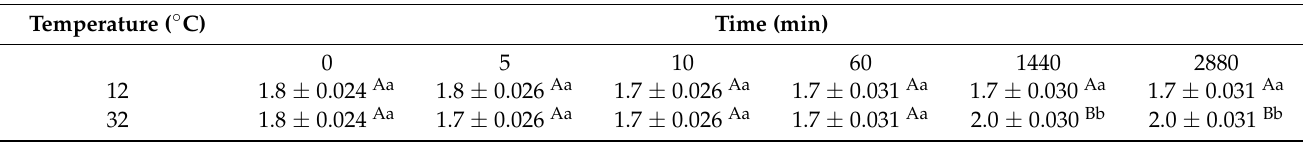
Table 1. Average E. coli populations in all studied simulated agricultural surface water analyzed by storage temperature and time. The temperature × time interaction was significant ( p = 0.0002) and does not include pH, turbidity, or treatment